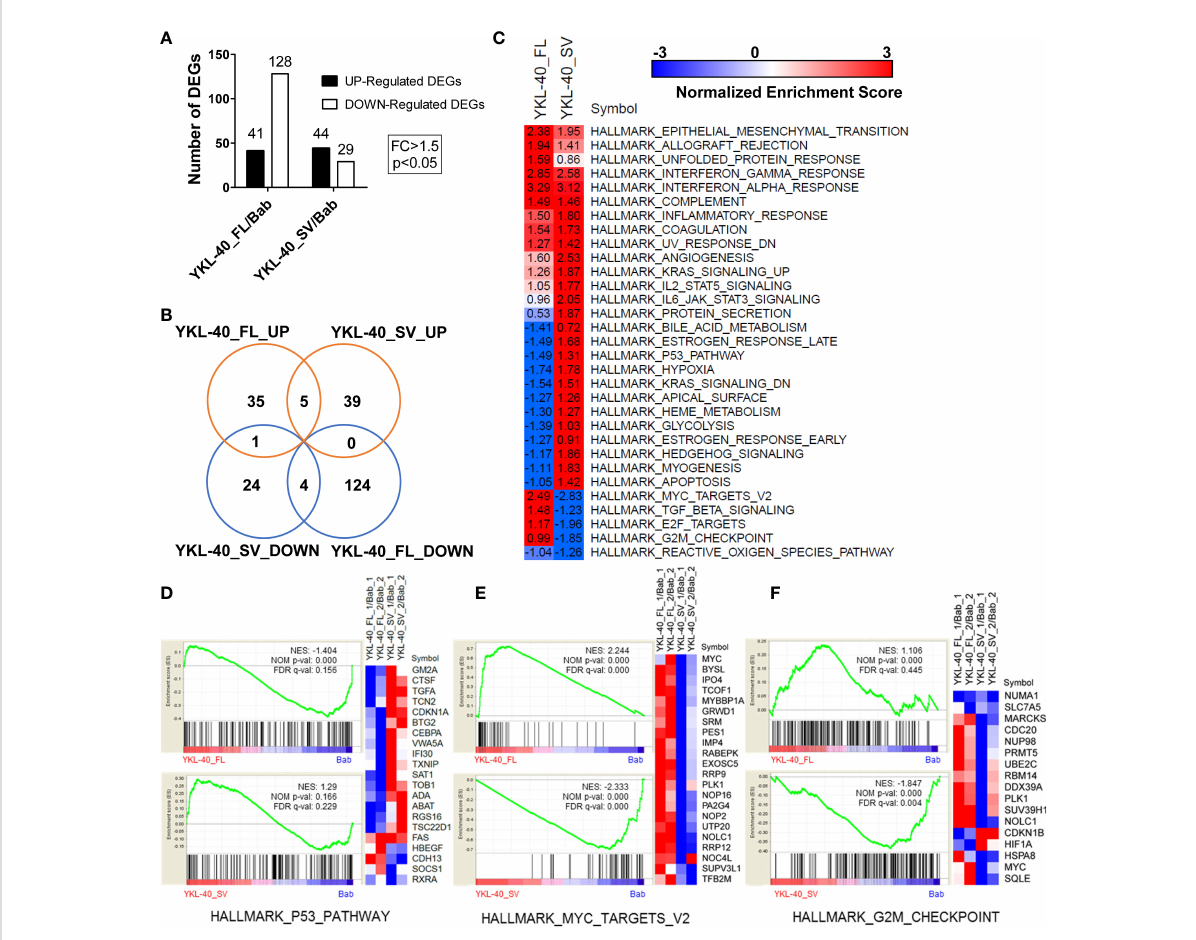
FIGURE 6 YKL-40 full-length (FL) and short variant (SV) isoforms elicit distinct transcriptional pro fi les in U251MG cells. (A) Transcriptional pro fi les of U251MG cells stably expressing YKL-40 FL and SV were generated by RNA-seq. Differentially expressed genes (DEGs) were identi fi ed by comparison to the control group using the following thresholding criteria: fold change > 1.5, p -value < 0.05. (B) A Venn diagram showing the common or speci fi c genes regulated by YKL-40 FL or SV was generated by an online tool. (C) GSEA enrichment analysis delineated cancer- related hallmark-associated gene sets. The hallmark gene sets from the MSigDB resource were utilized in the analysis, NES, Normalized Enrichment Score; positive and negative values of NES indicated up- and downregulated gene expression patterns, respectively (FDR q -value <5%, q -value<0.05). (D – F) Selective hallmark gene sets showing the opposing effects of two different isoforms were generated by the GSEA tool kit. A heatmap showing the RNA expression levels (relative expression ratio compared to control) of the DEGs included in certain gene